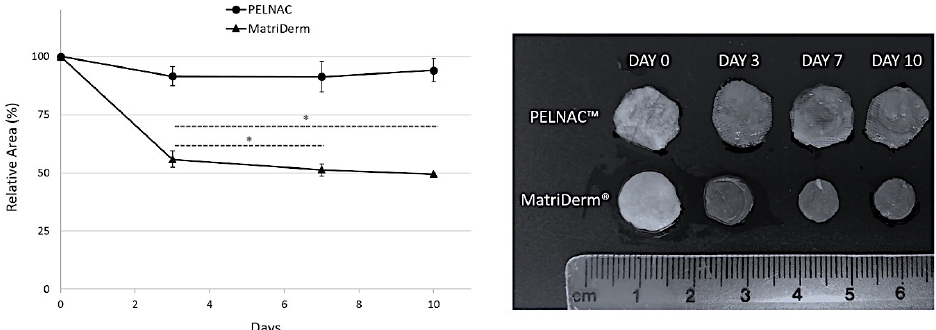
Figure 6. Matrix contraction data. While the size of PELNAC ™ barely changed by 6% after ten days in culture, a significant reduction in the size of MatriDerm ® was observed. The bars on the graph denote the standard error of mean ( n = 4). * p < 0.05.